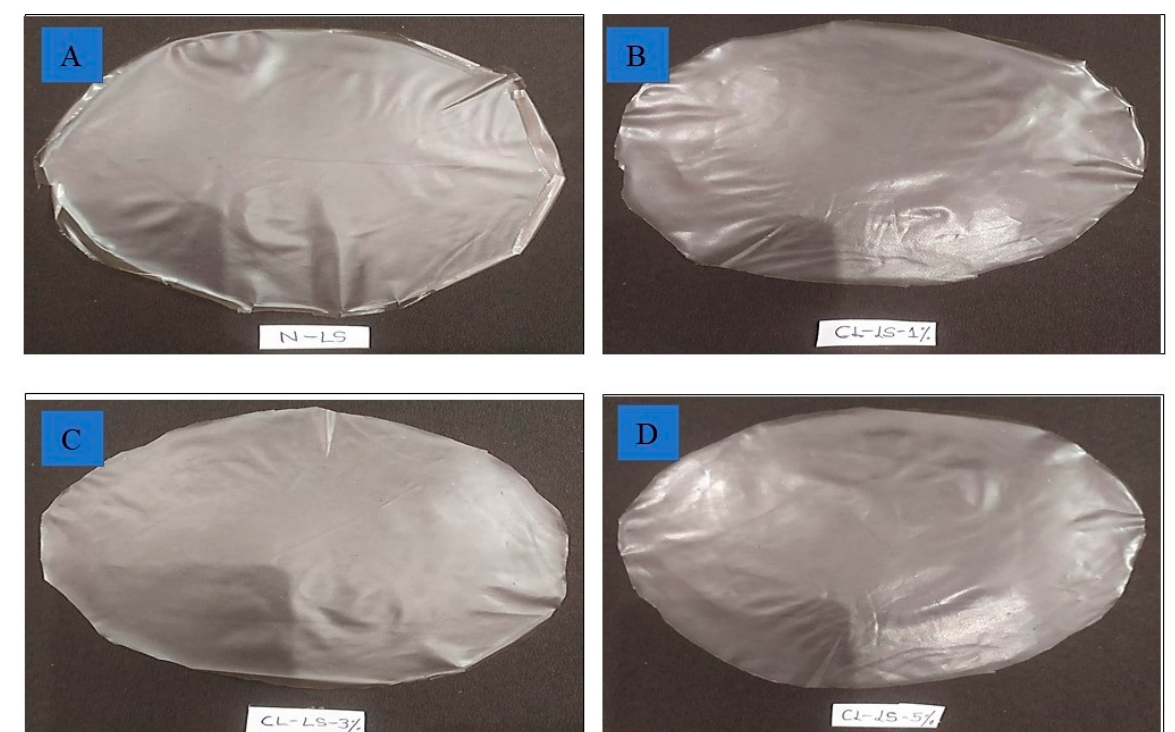
Figure 4. Images of native and modified cross ‐ linked lotus seed starch films. ( A ) Native LSF, ( B ) CL ‐ LSF ‐ 1, ( C ) CL ‐ LSF ‐ 3, ( D ) CL ‐ LSF ‐ 5.